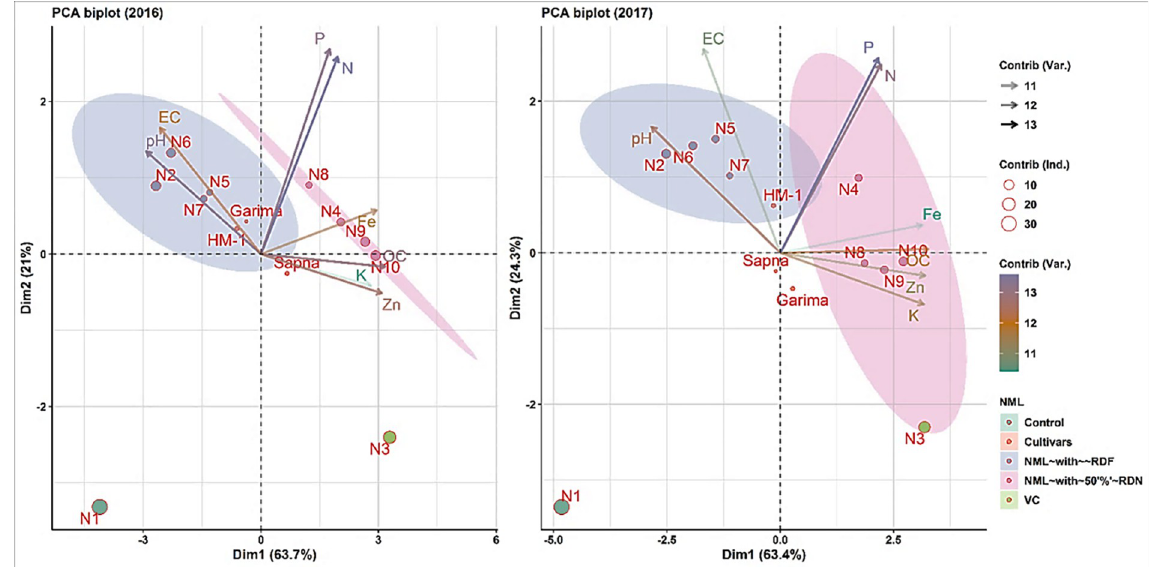
Fig 8. Graphic biplot for principal components (PC1 and PC2) for soil properties after harvest of first (A) and (B) second years.